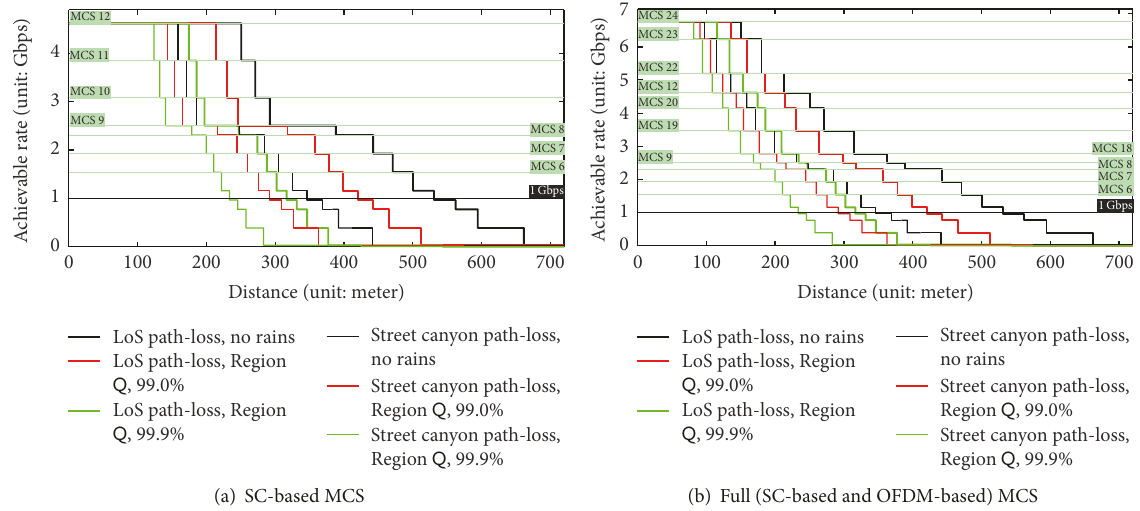
Figure 7: Link budget estimation for backhaul link (MAA8-MAA8, as illustrated in Figure 6(c)) with various path-loss models and rain